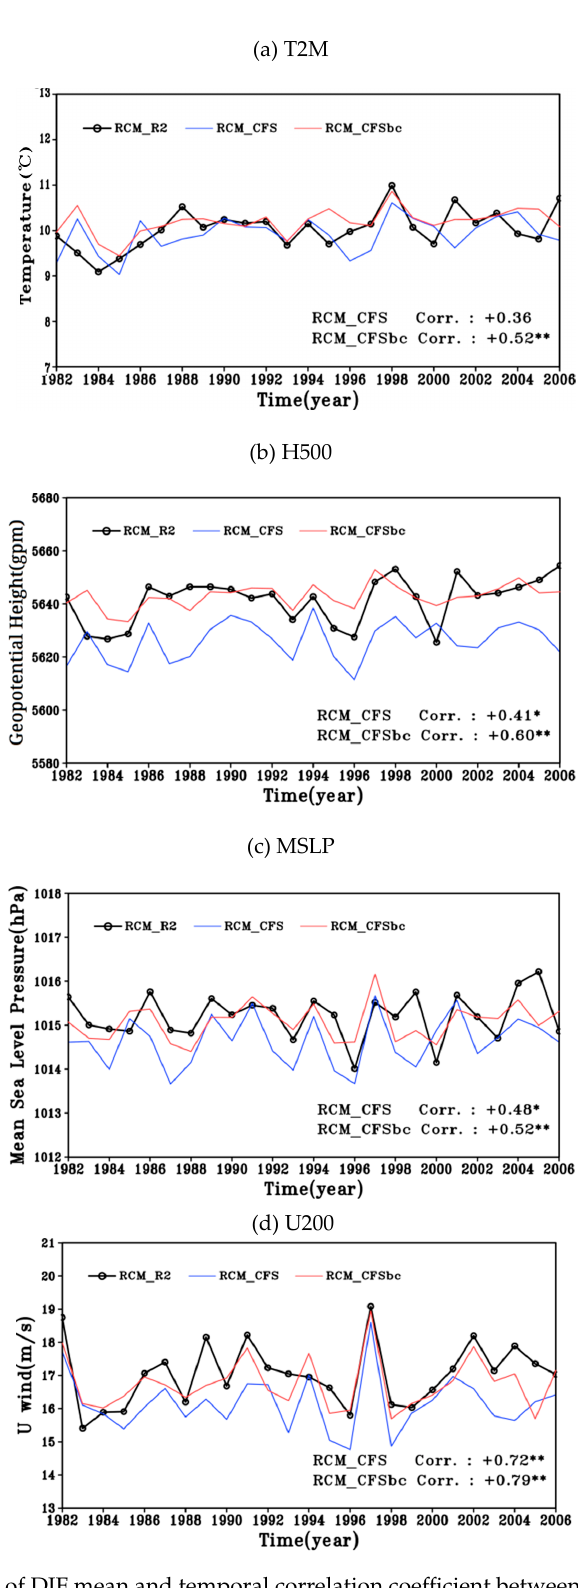
Figure 4. Time series of DJF mean and temporal correlation coefficient between RCM_R2 (black line) and RCM_CFS (blue line), RCM_CFSbc (red line) experiment for ( a ) 2 m temperature, ( b ) 500 hPa geopotential height, ( c ) mean sea level pressure, and ( d ) 200 hPa zonal wind over Asian region (70° E–162° E, − 10° S–68° N) during 1982–2006 (* and ** indicate that correlation coefficient values are statistically significant at the 95% and 99% confidence levels, respectively).